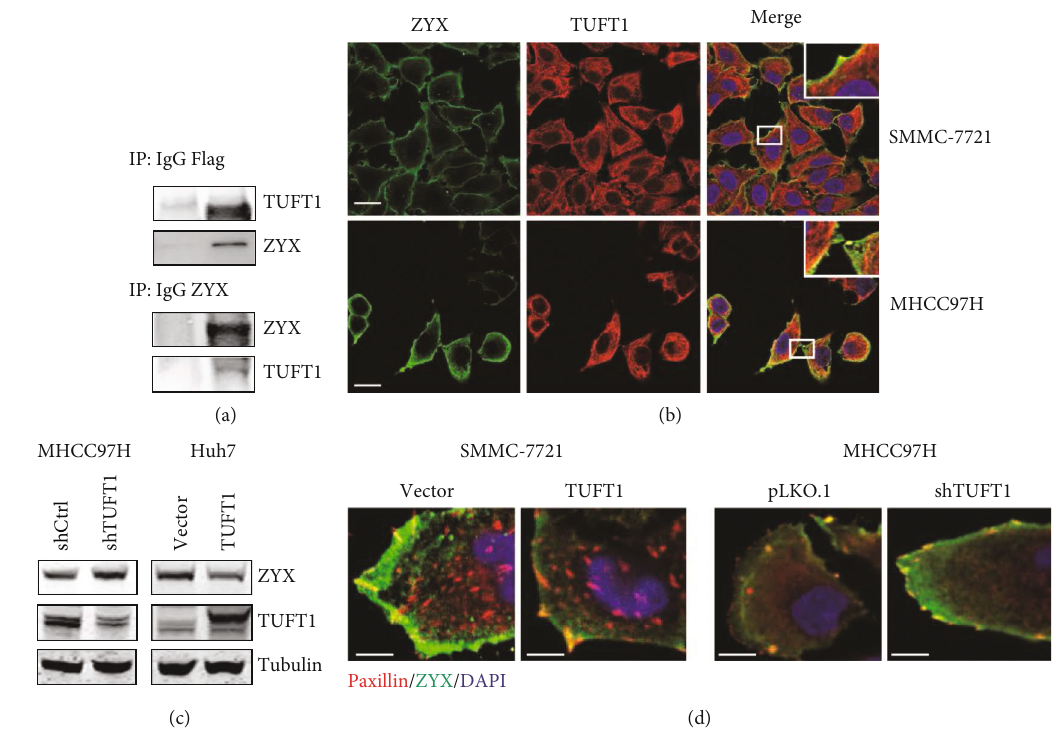
Figure 6: TUFT1 suppressed ZYX expression and inhibited its recruitment to focal adhesion. (a) Co-IP of TUFT1-Flag with an anti-Flag antibody (upper panel), or with an anti-ZYX antibody (down panel), followed by western blot analysis in Huh7 cells. (b) Co- immuno fl uorescence analysis of ZYX and TUFT1 in HCC cells, with colocalization at focal adhesions enlarged with a white rectangle; scale bar: 10 μ m. (c) Western blot analysis of ZYX in TUFT1-overexpressing or knockdown cells. (d) Co-immuno fl uorescence analysis of ZYX and paxillin in TUFT1-overexpressing or knockdown HCC cells. Colocalization in yellow at cell-substratum adhesion showed mature focal adhesions. Scale bar: 5 μ